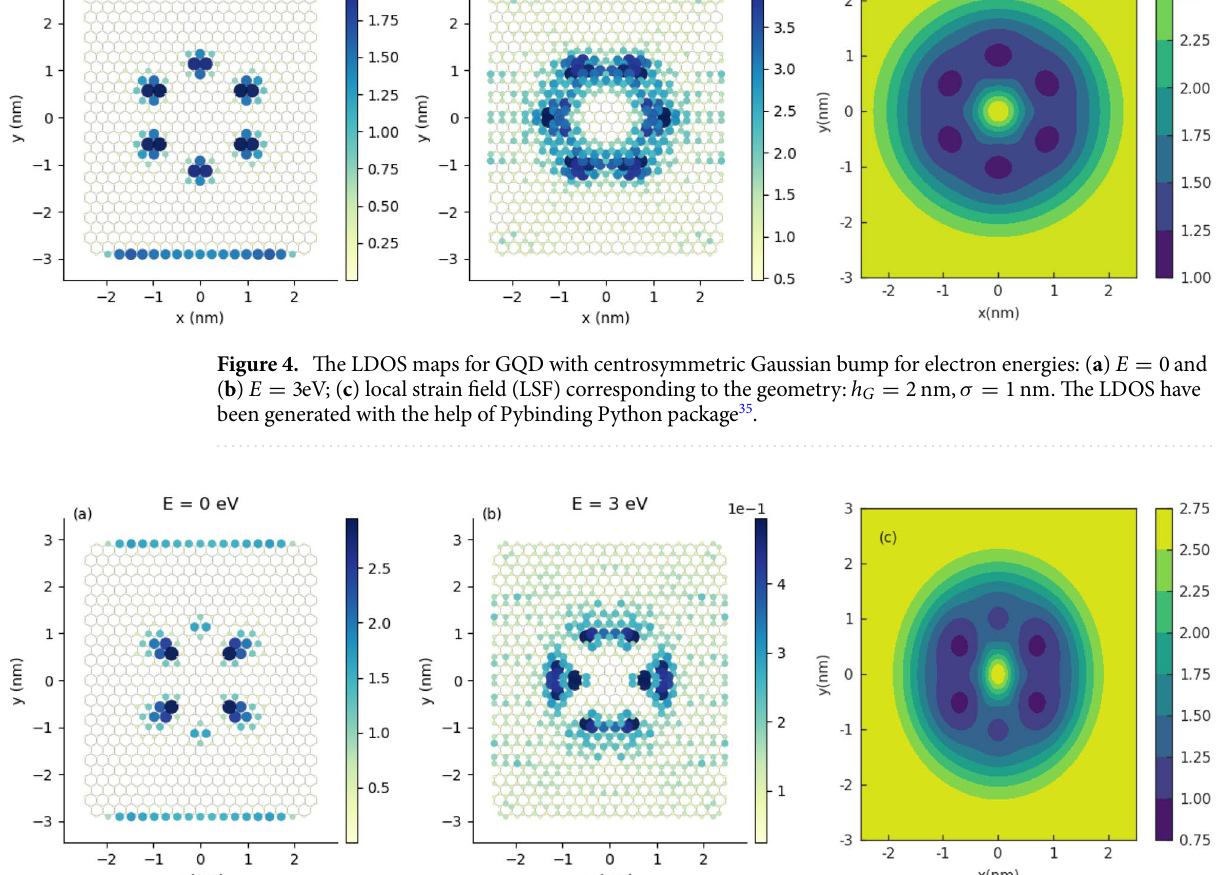
Figure 5. The LDOS maps for GQD with non-centrosymmetric Gaussian bump for electron energies: ( a ) E and ( b ) E